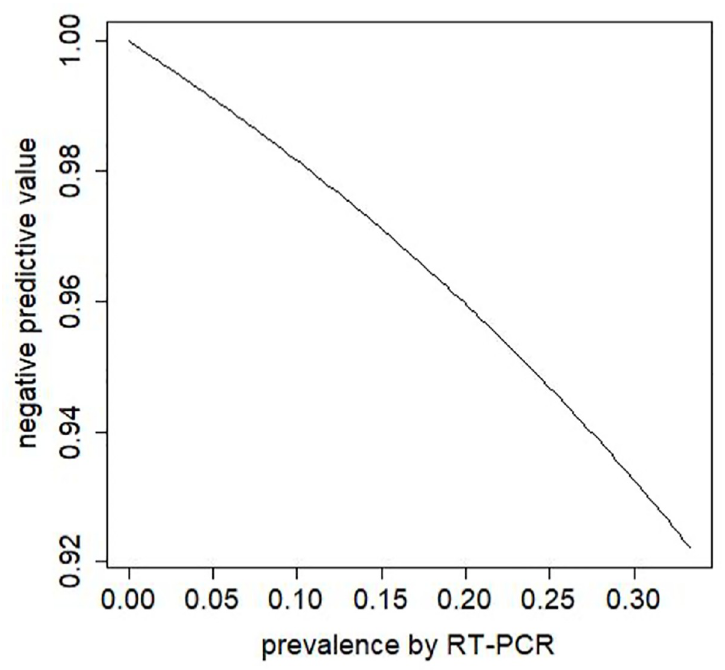
Fig 2. Negative predictive value (NPV) of the Abbott IgG test. NPVs were defined for the values of sensitivity and specificity in Table 2 (83 and 100% respectively), as a function of prevalence as determined by RT-PCR [25]. https://doi.org/10.1371/journal.pone.0256566.g002 (percentage of results in agreement) was 90.1%. Among the 14 RT-PCR positive/IgG negative tom onset.